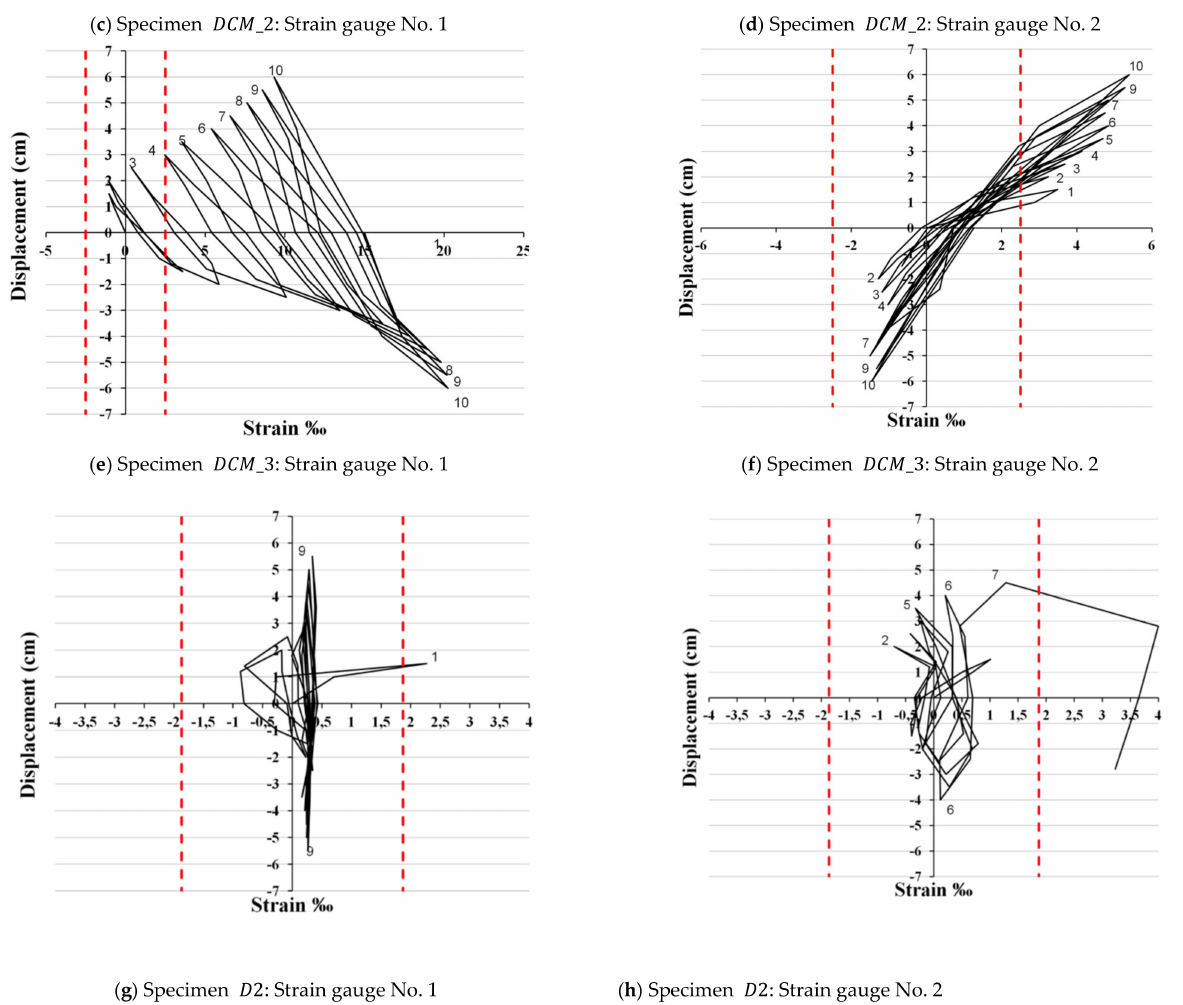
Figure 8. Plots of the load point displacement versus strain of reinforcement: ( a ) Specimen DCM _1, Strain gauge No. 1; ( b ) Specimen DCM _1, Strain gauge No. 2; ( c ) Specimen DCM _2, Strain gauge No. 1; ( d ) Specimen DCM _2, Strain gauge No. 2; ( e ) Specimen DCM _3, Strain gauge No. 1; ( f ) Specimen DCM _3, Strain gauge No. 2; ( g ) Specimen D 2, Strain gauge No. 1; ( h ) Specimen D 2, Strain gauge No. 2. Yield strains of specimens’ DCM _1, DCM _2, and DCM _3 were 2.5‰, while the yield strain of specimen D 2 was